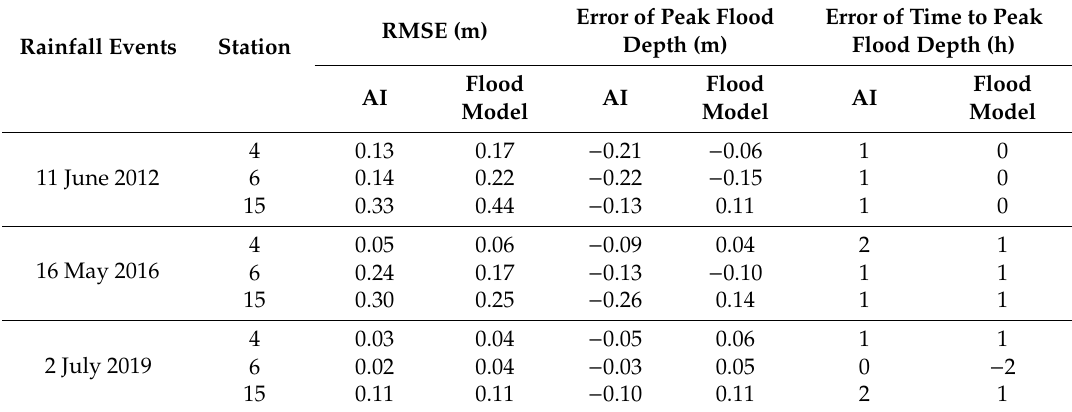
Table 2. Error analyses of the measured / predicted pluvial flood depths comparison.